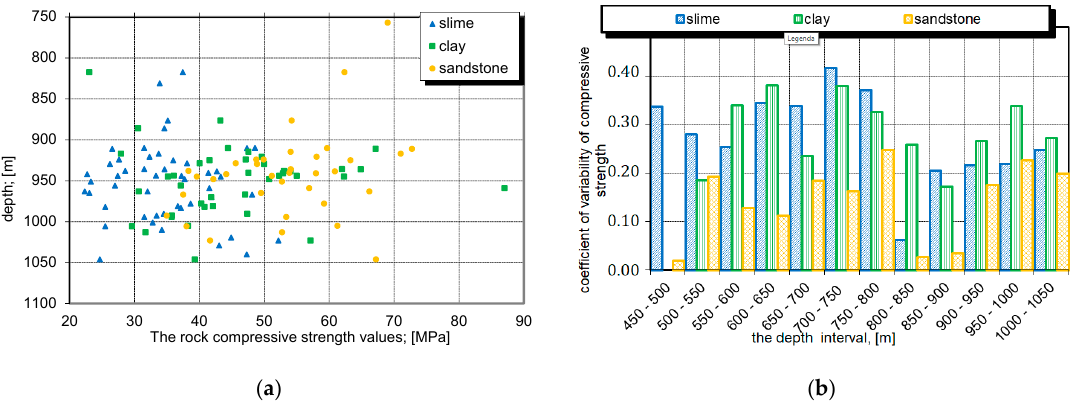
Figure 4. Distribution of the rock compressive strength ( a ) values depending on the depth. Reproduced from [36], Wyd. IGSMiE PAN: 2007., ( b ) variability depending on the depth. Reproduced from [36], Wyd. IGSMiE PAN: 2007.